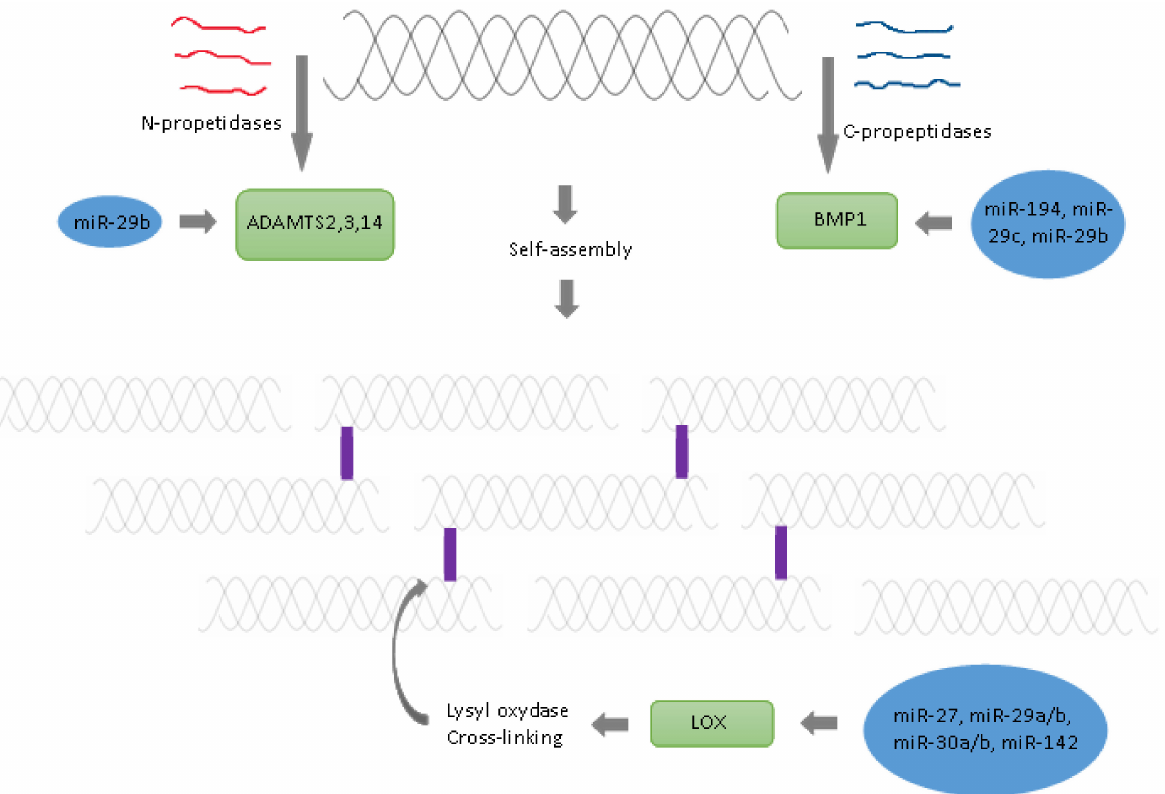
Figure 2. Schematic representation of the key steps of collagen synthesis in the extracellular